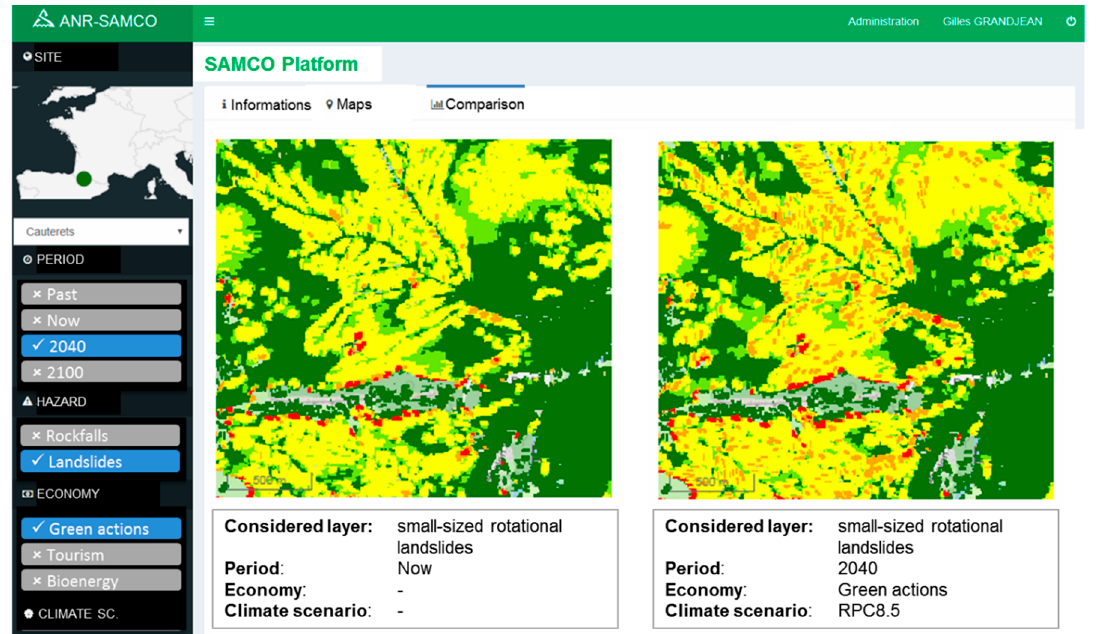
Figure 7. “Print screen” of the SAMCO Web-platform showing the landslide hazard map for the scenario: Site = Cauterets, Period = 2040, Hazard = Landslides, Economy = Green actions, climate = RCP8.5 at present days ( left ) and at horizon 2040 ( right ). The locations where the landslide hazard level goes from low to moderate are clearly visible.